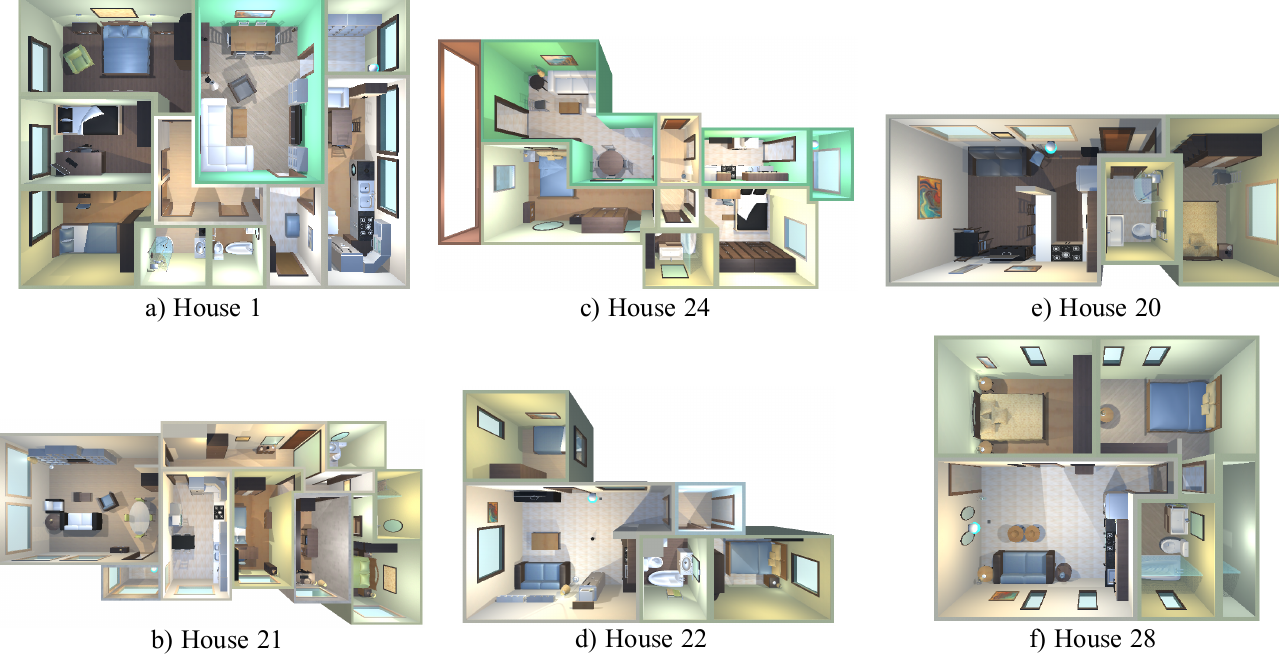
Figure 5. Environments from Robot@VirtualHome ecosystem used in the experimental validation of the method. Large, medium, and small size environments are depicted in ( a , b ), ( c , d ) and ( e , f ),